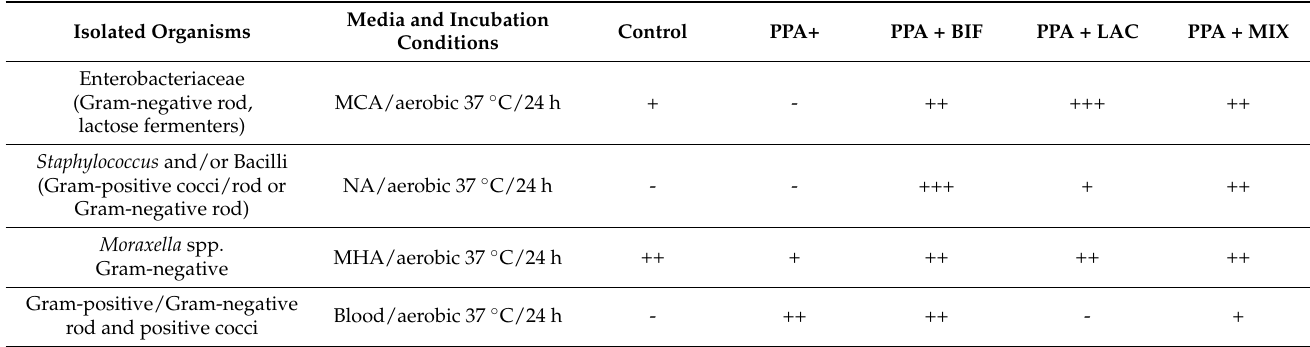
Table 4. Estimated changes in microorganisms in all groups. MCA—MacConkey agar; NA—nutrient agar; MHA—Mueller Hinton agar; blood agar. ((-) No growth, (+) weak growth, (++) medium growth, and (+++) strong